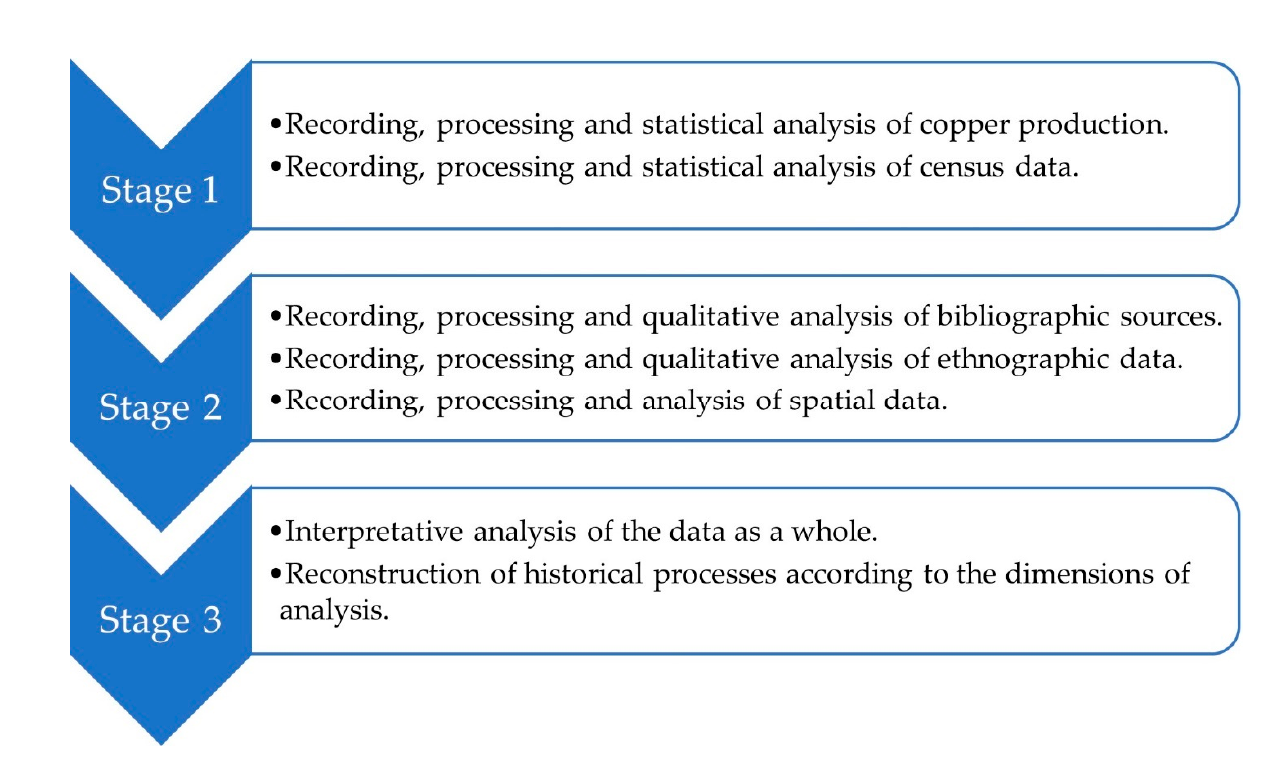
Figure 2. Workflow diagram of data recording, processing, and analysis activities.